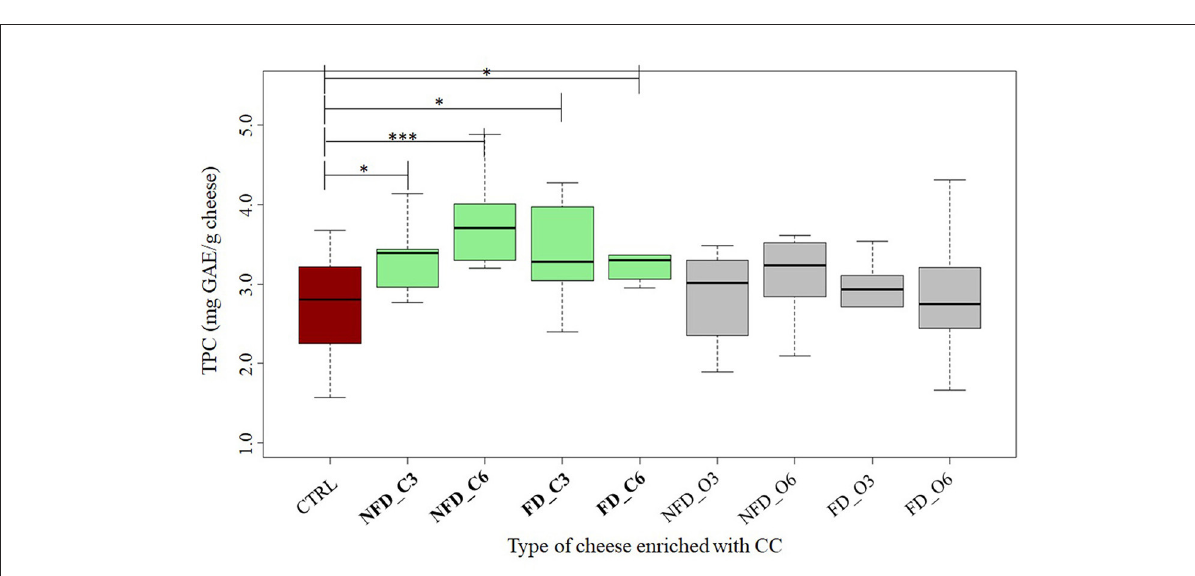
FIGURE4 Total Polyphenol Content (TPC) in cheeses added with Cornelian cherry (CC) expressed in mg GAE/g cheese. CTRL: controls in red; NFD_C3: 0.3% not freeze-dried conventional CC cheeses; NFD_C6: 0.6% not freeze-dried conventional CC cheeses; FD_C3: 0.3% freeze-dried conventional CC cheeses; FD_C6: 0.6% freeze-dried conventional CC cheeses; FD_O3: 0.3% freeze-dried organic CC model cheeses; FD_O6 0.6% freeze-dried organic CC cheeses; NFD_O3: 0.3% not freeze-dried organic CC cheeses; NFD_O6: 0.6% not freeze-dried organic CC cheeses. The thick horizontal black bars indicate the medians; the boxes indicate the range between the first (25th percentile) and the third quartile (75th percentile). The whiskers represent extreme values. Significant differences between CTRL and enriched cheeses are indicated by an asterisk (*: p < 0.05; ***: p < 0.001). The number of replicates: n = 3 for all enriched model cheeses; n = 6 for CTRL. The TPC boxes significantly different are in green